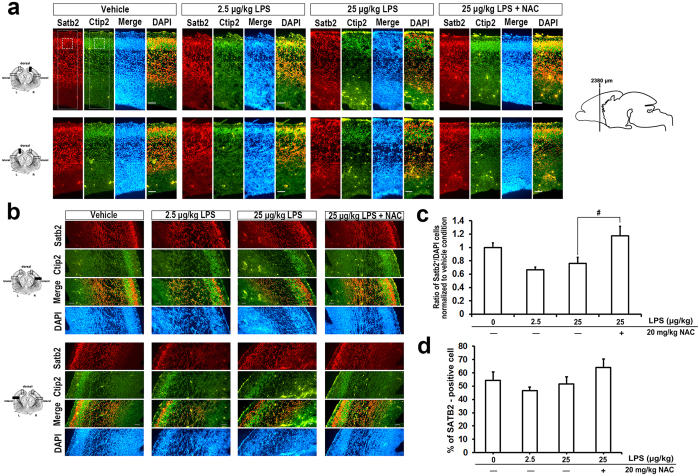
LPS induced impairment in neural development was recovered by application of NAC.Coronal sections of indicated GD 18 rat embryonic brains were immunostained for Satb2, Ctip2 and DAPI. Satb2 expressing neurons are mainly localized in layer II/III and moderately in layer VI, while Ctip2 labels layer V cells. Merged image is composed of Satb2 (red), Ctip2 (green). DAPI (blue) represents each nuclei. Five embryo brains were randomly selected from at least three different pregnant rats. In each brain, two coronal sections near the site around 2380 μm from the front of olfactory bulb were analyzed. Representative images of the sections at cortical (a) dorsal and (b) lateral areas are shown. Comparing to vehicle-exposed group, Ctip2+ cells expressed extendedly in LPS treated group, significantly in higher dose. Satb2+ neurons were more dispread and disorganized after exposure to high dose of LPS. The effects of NAC returned abnormal cortical lamination characteristics to control levels. Scale bar, 50 μm. (c) displays the quantitative results that the quantitative results of the small dashed square. The dorsal area of cortex is divided into 9 equivalent bins, with the border between bin 1 and bin 2 corresponding the cortical plate as the dotted area. Ratio of Satb2+/DAPI in each condition is normalized to the vehicle. LPS caused lesser Satb2+ cells expressed in cortical plate, and application of NAC effectively restored the location of laminar Satb2 distribution. #p < 0.05 by ANOVA followed by Tukey-Kramer Multiple Comparisons Test. (d) displays the quantitative results of the large dotted square, as same as the area counted for BrdU. Number of Satb2+ cell was normalized to the number of DAPI+ cell. There is no significant differences in the total number of Satb2+ cell among groups. nsp > 0.05 by ANOVA followed by Tukey-Kramer Multiple Comparisons Test.